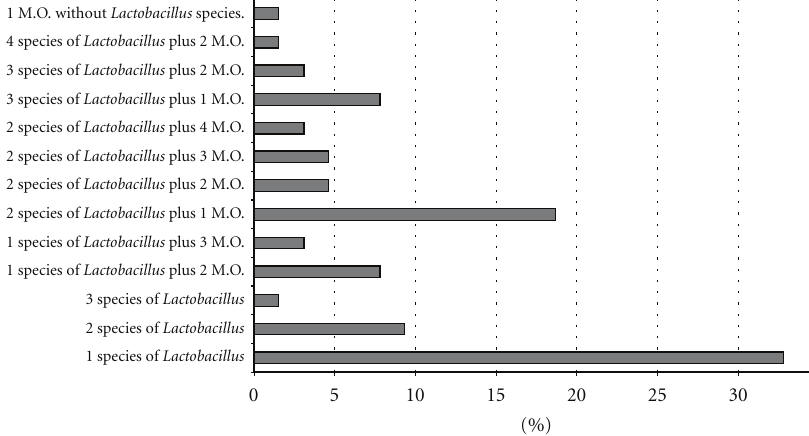
Figure 4: Profile of microorganisms identified in vaginal tract of women studied ( n = 64). M.O. = microorganism (any microorganism di ff erent of Lactobacilli